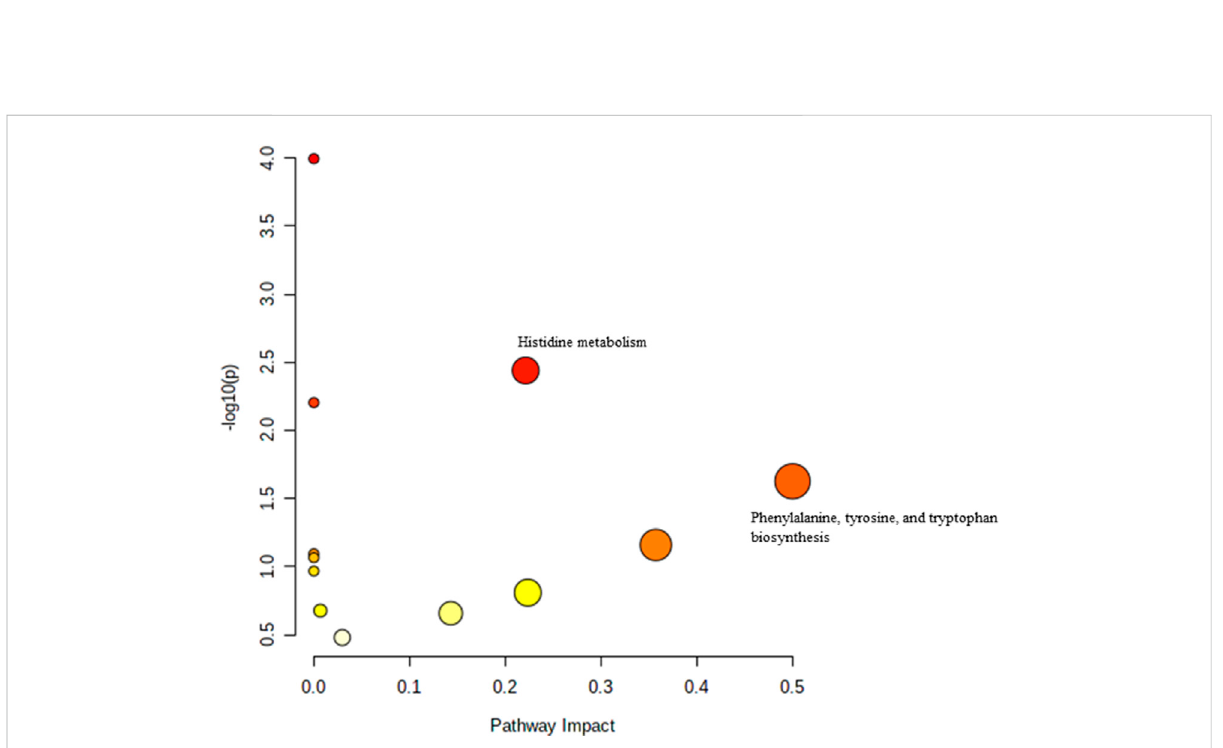
FIGURE 7 Biochemical pathway analysis of metabolites pro fi led for OC vs.